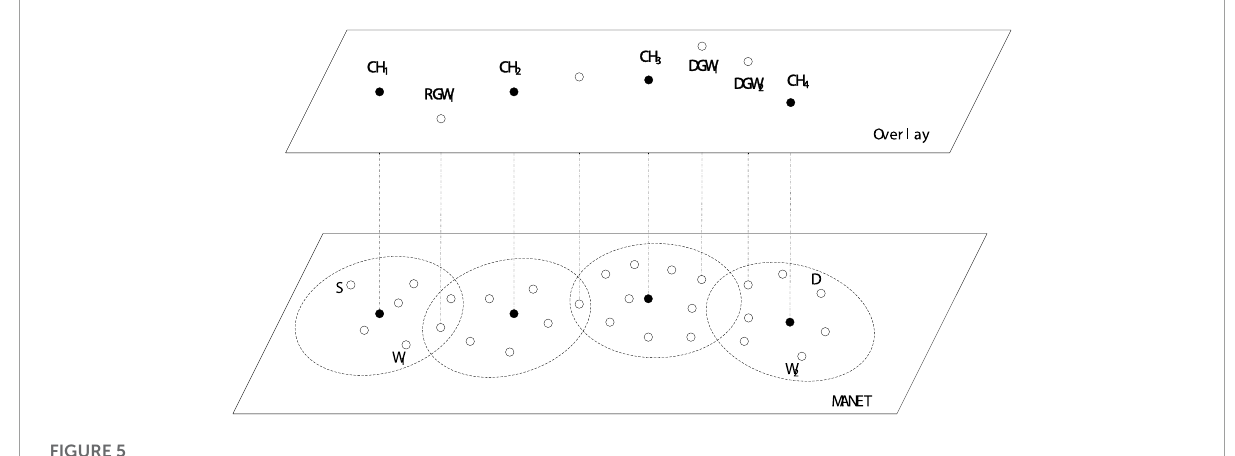
FIGURE 5 Clusters and overlay layer with clusterheads and gateways.